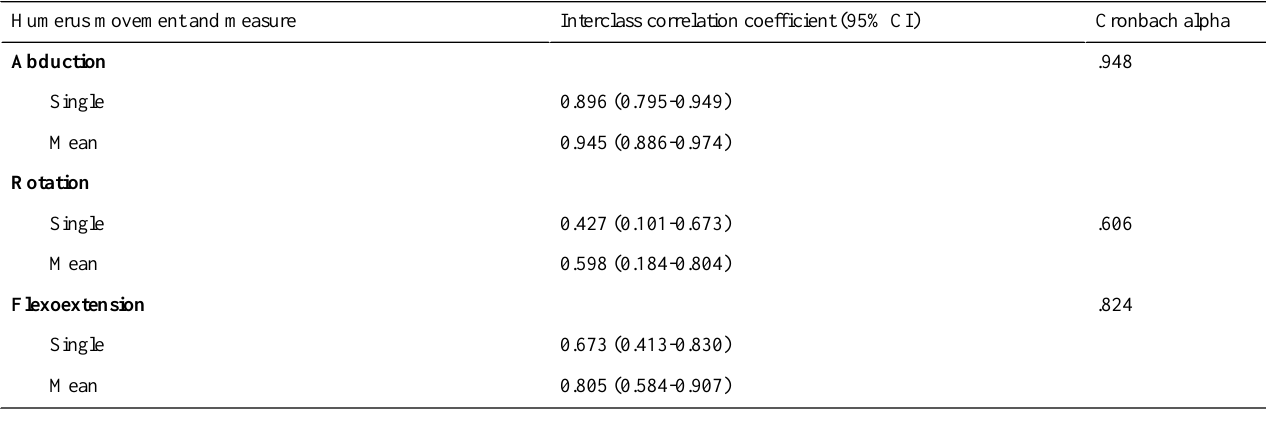
Table 5. Interclass correlation coefficient interdevices for scaption